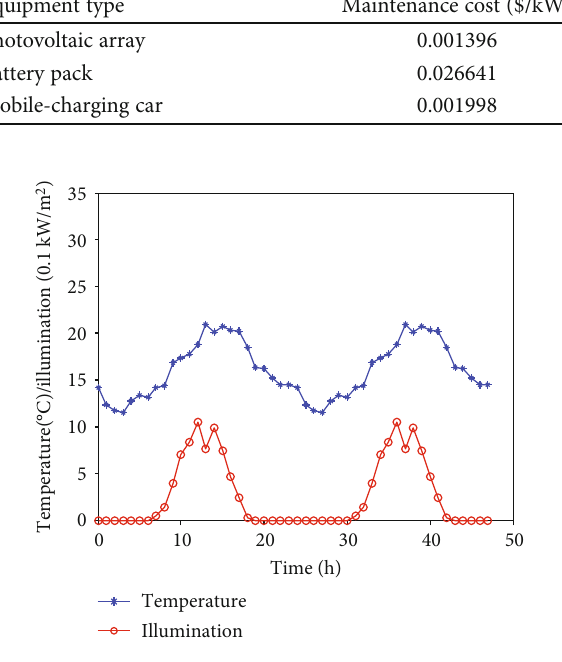
Figure 4: Date of the forecast 48h.